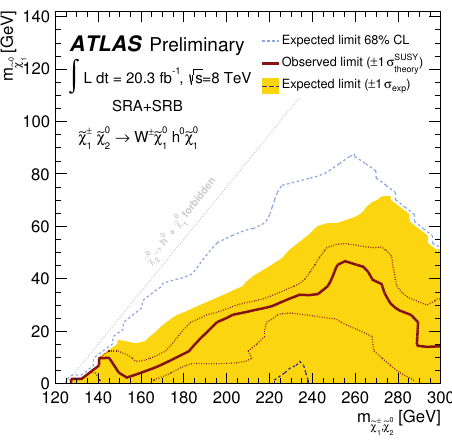
± / ˜ χ 0 1 2 masses. [11]